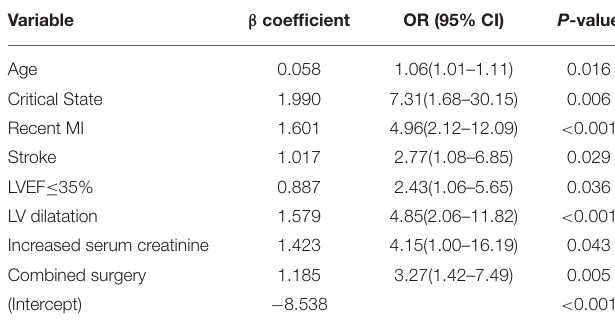
TABLE 2 | Univariable Logistic Regression Analysis of predictors associated with in-hospital mortality in the Training Cohort. Variables OR (95%CI) P -value